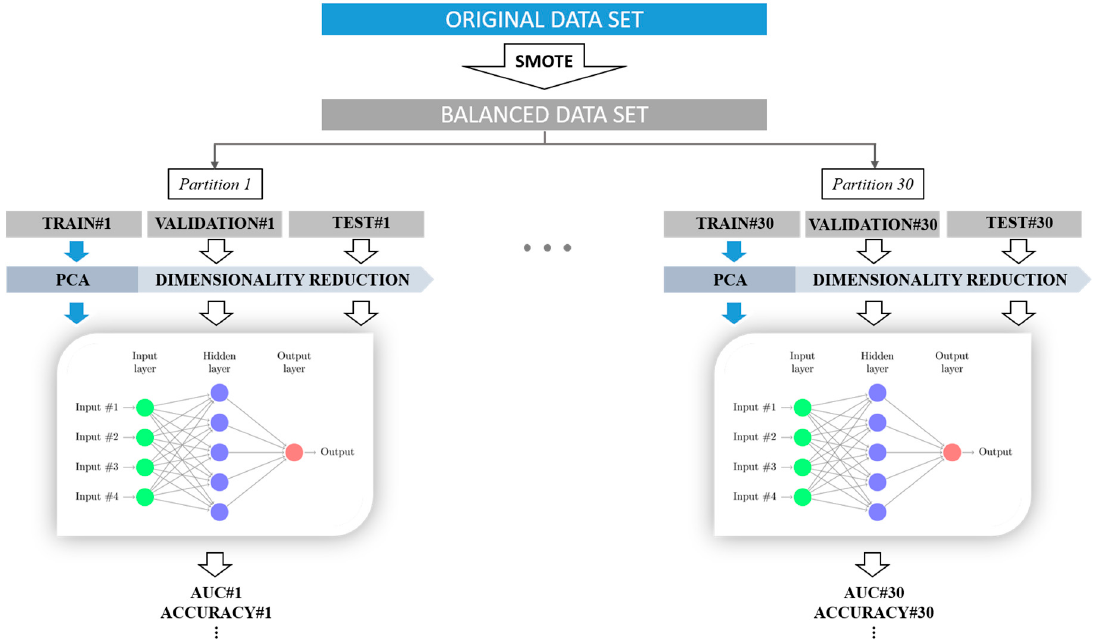
Figure 2. Diagram of the method used to train and validate the labor prediction model with 7- and 14-day time horizons in threatened preterm labor women.